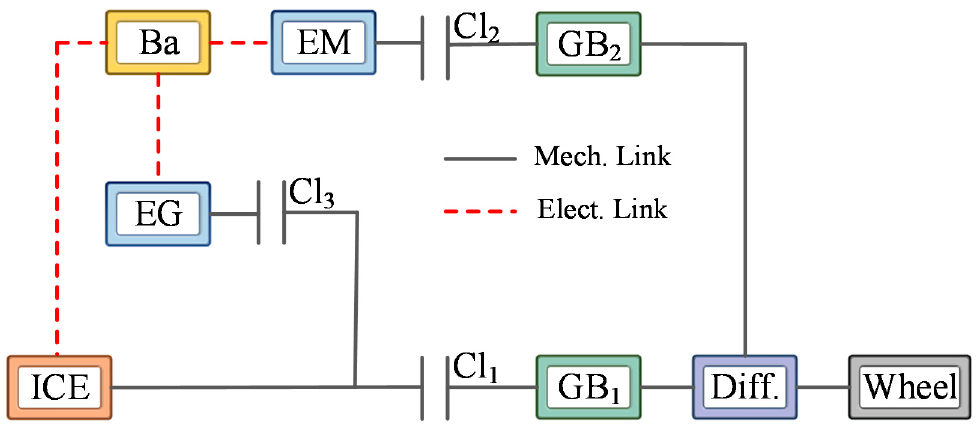
Figure 1. Powertrain schematic of the tested hybrid electric vehicles (HEV).